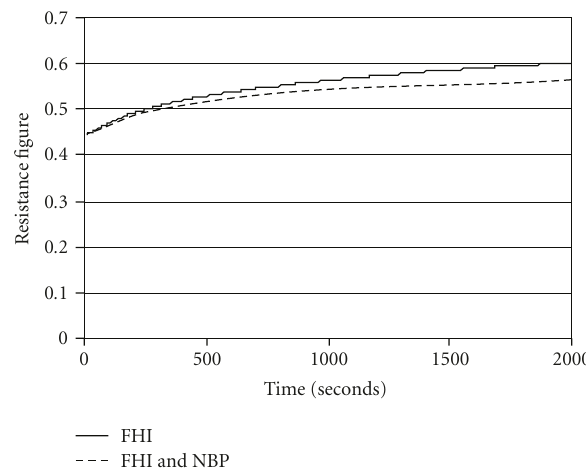
Figure 1: The resistance figure for FHI with and without neutral behavior period